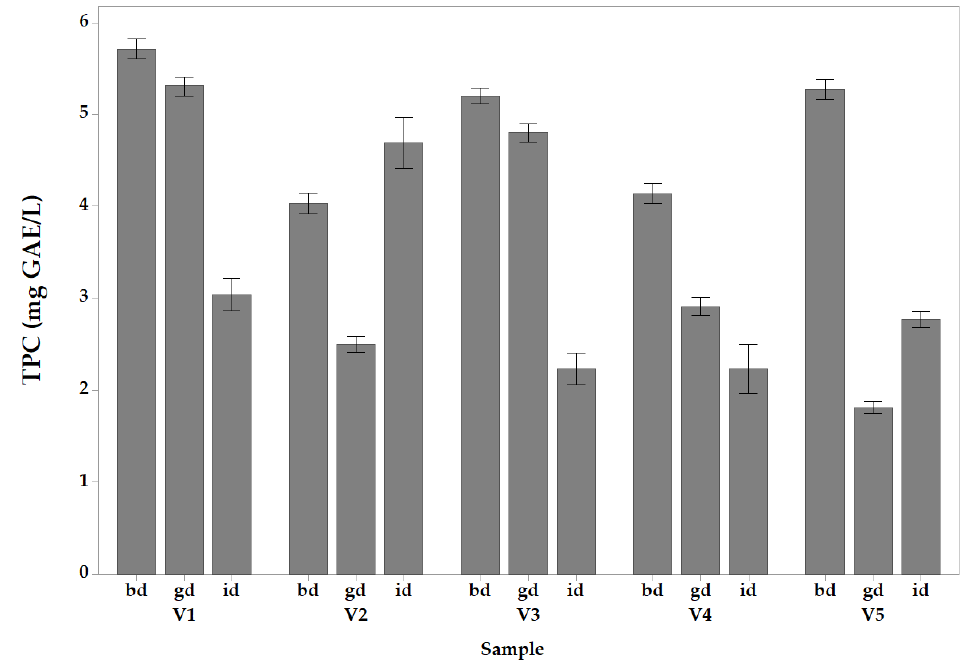
Figure 6. Interval plots of total polyphenol content (TPC) vs. samples before digestion (bd); and after gastric digestion (gd); intestinal digestion (id). V1 = banana peel vinegar aged for 1 year, produced without boiling the peels boiling aged for 1 year, V2 = banana peel vinegar aged for 3 years, produced without boiling the peels boiling aged for 3 years, V3 = banana peel vinegar aged for 2 years, produced with peels boiling the peels aged for 2 years, V4 = commercial balsamic vinegar produced from concentrated apple juice and caramel aged in oak barrels for 1 year, V5 = Modena commercial vinegar obtained from concentrated grape must. The error bars represent a 95% confidence interval for the mean.